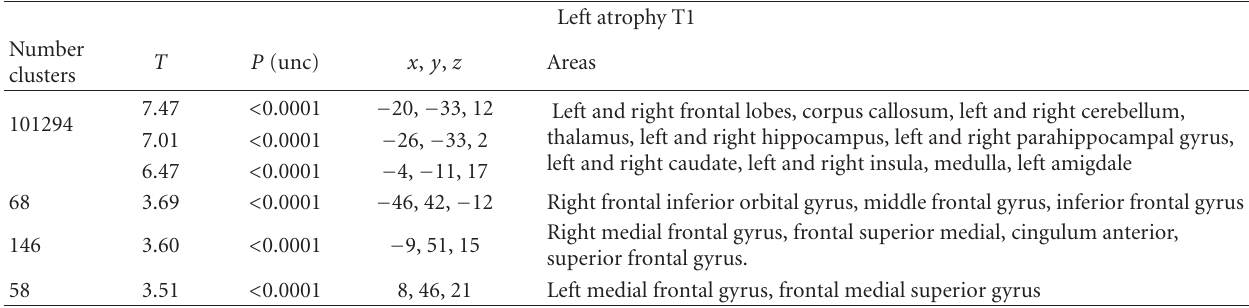
Table 2: Areas with WM atrophy in patients with left HA, from T1-weighted analysis. Left atrophy T1